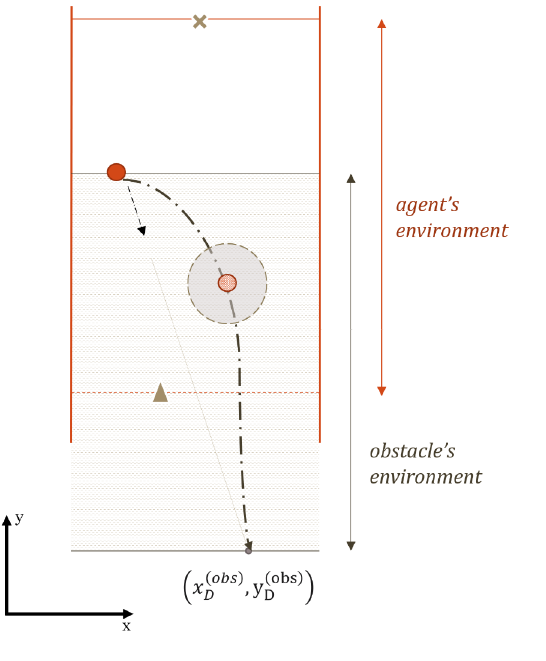
Figure 6. Point-of-conflict of a pedestrian